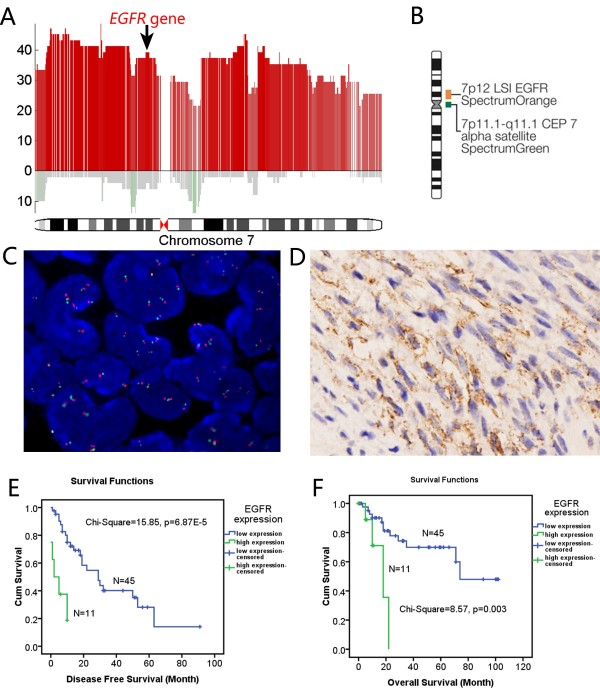
Genetic amplification and increased expression of EGFR protein in TMUCIH MPNST samples and its clinical significance. (A) Large-fragment amplification of chromosome 7p, including the EGFR gene. Arrow shows the location of the EGFR gene, which is amplified in 37% of the cases. (B) The EGFR/CEP7 FISH probe. (C) FISH analysis detected amplification of the EGFR gene in a representative tumor sample. Green signal represents the centromere and orange signal represents the EGFR gene. (D) EGFR protein expression in representative human MPNST tissue. (E,F) Patients whose MPNST expressed a high level of EGFR had shorter disease-free survival (E) and shorter overall survival (F).